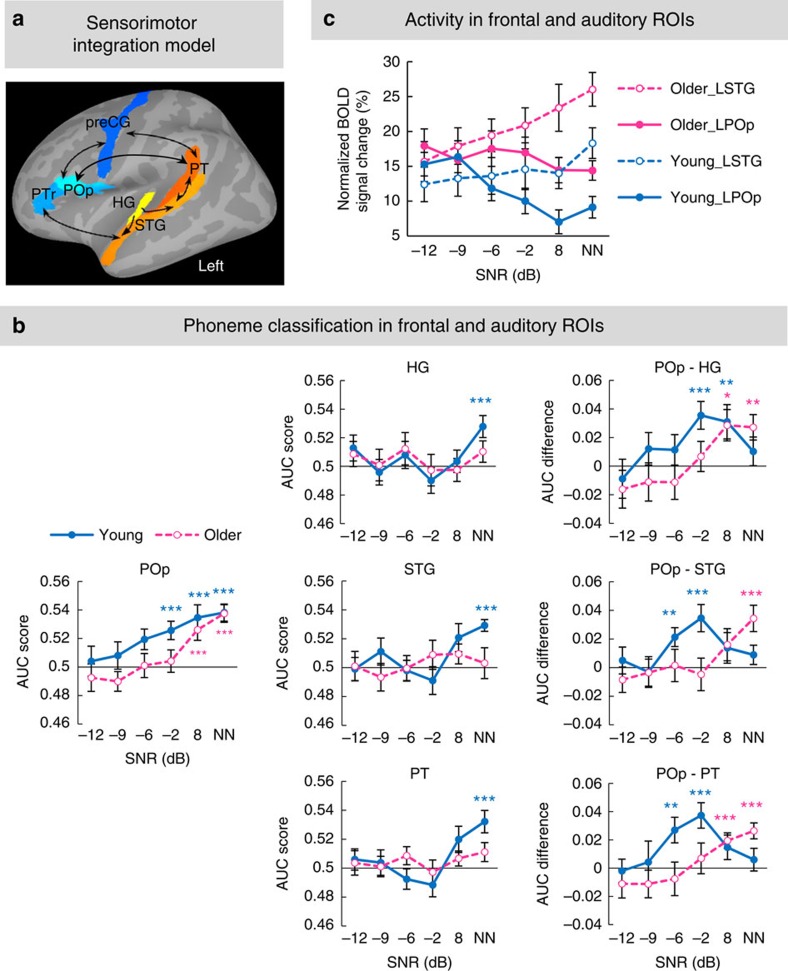
Phoneme classification performance and BOLD activity in frontal and auditory ROIs.(a) Six anatomical ROIs in the left hemisphere (3 frontal ROIs: POp, PTr and preCG; 3 auditory ROIs: HG, STG and PT) composing the sensorimotor mapping model are displayed on an inflated surface. The model was modified from Fig. 5 in Rauschecker and Scott13. (b) The AUC scores as a function of SNR in the left POp (left panel) and each auditory ROI (HG, STG and PT, middle panel) are shown for each group. ***P<0.005 by one-sample t-tests showing conditions with significant classification in young (blue asterisks) or older (red asterisks) adults. Differences in the AUC score between the left POp and each auditory ROI as a function of SNR are shown for each group in the right panel. *P<0.05; **P<0.01; ***P<0.005 by one-sample t-tests indicating SNRs at which classification in the POp was stronger than in one of auditory ROIs in young (blue asterisks) or older (red asterisks) adults. Notably, sensorimotor integration between frontal and auditory regions as a function of SNR was right shifted in older adults. (c) BOLD activity as a function of SNR in the left POp (solid lines) and left STG (dash lines) anatomical ROIs in young (blue lines) and older (red lines) adults.